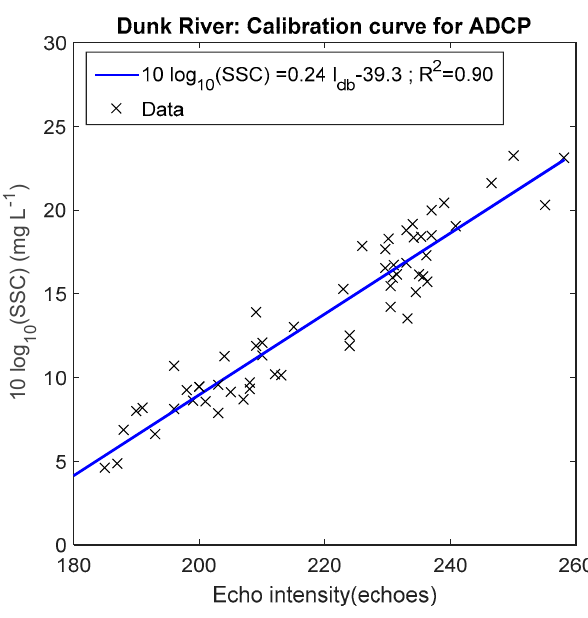
Figure 3. Suspended sediment calibration curve for the Sentinel V-ADCP.